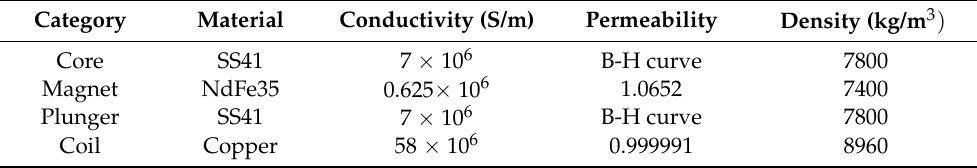
Table 1. Material properties.